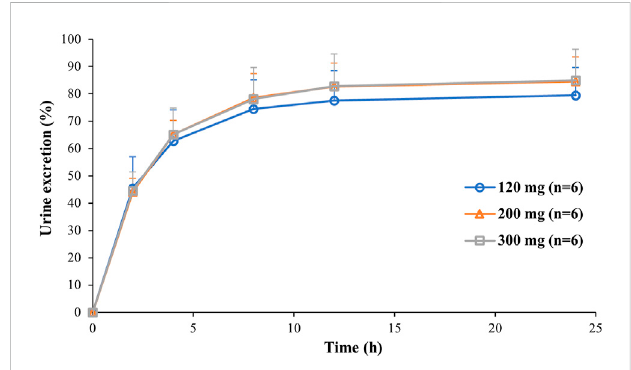
FIGURE 6 Averageurinaryexcretion – timecurvesofetimicinafterintravenous administration of etimicin (120, 200, 300 mg) in Chinese